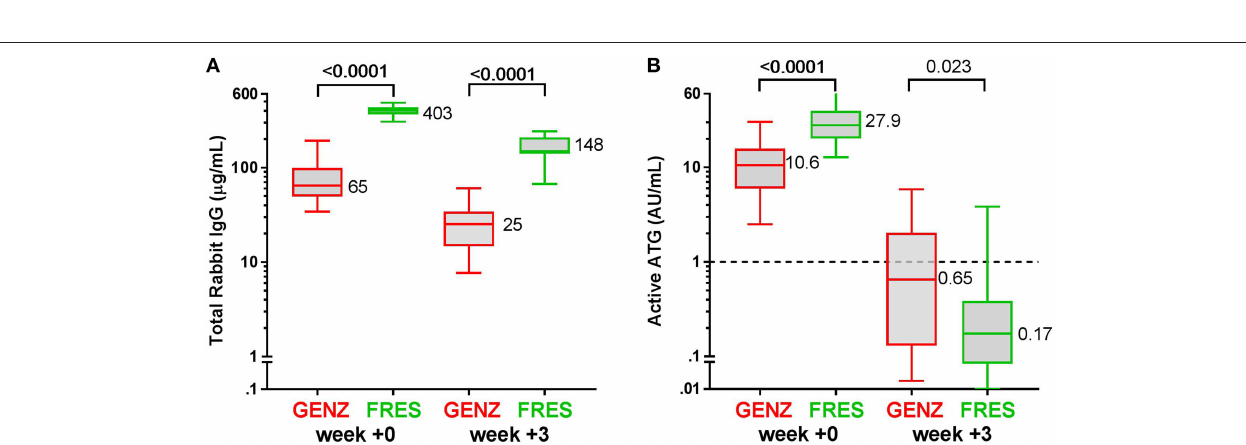
FIGURE 2 | Box plots of serum/plasma concentration of total Rabbit IgG (total ATG) and active ATG in ATG-GENZ (Genzyme, red) and ATG-FRES (Fresenius, green) treated patients. (A) Total Rabbit IgG concentration in ATG-FRES treated patients at week 0 (day of graft infusion) and week + 3 (expected time of neutrophil engraftment) is significantly higher in comparison with ATG-GENZ treated patients. (B) Active ATG concentration at week 0 in ATG-FRES treated patients is significantly higher in comparison with ATG-GENZ treated patients, but at week + 3 the serum/plasma level of active ATG in ATG-FRES treated patients is lower than in ATG-GENZ treated patients (0.17 vs. 0.65